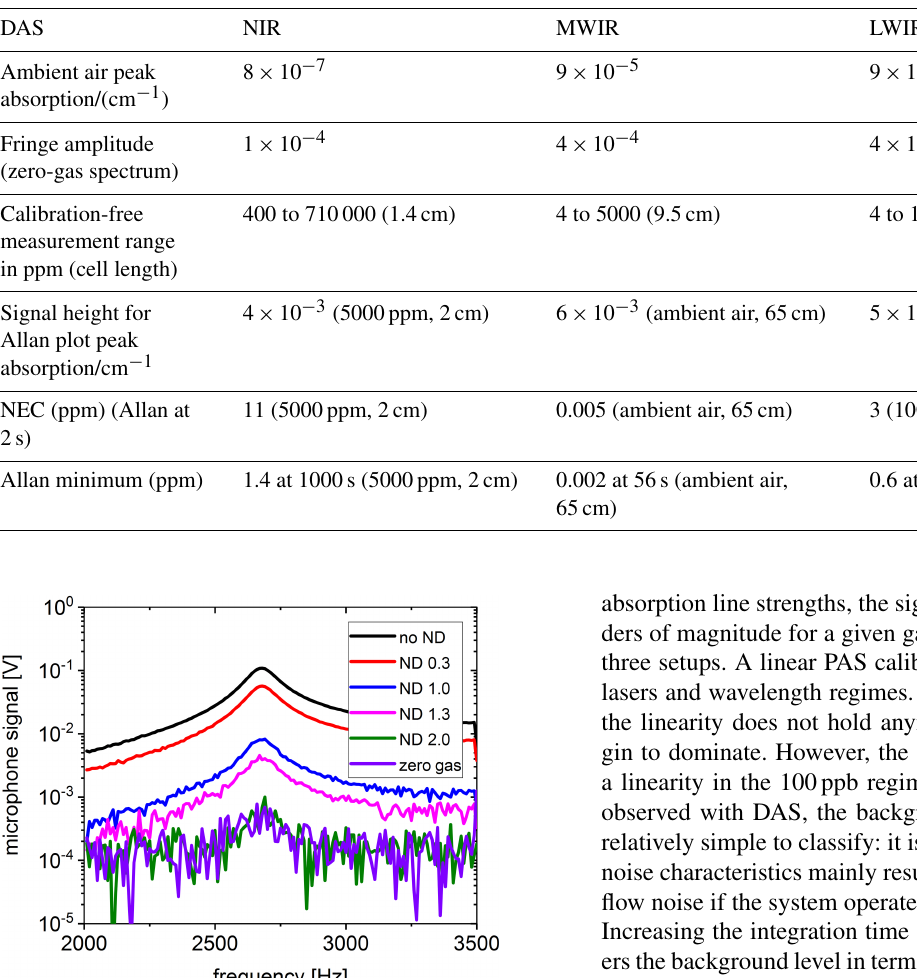
Table 4. Results of the DAS measurements.